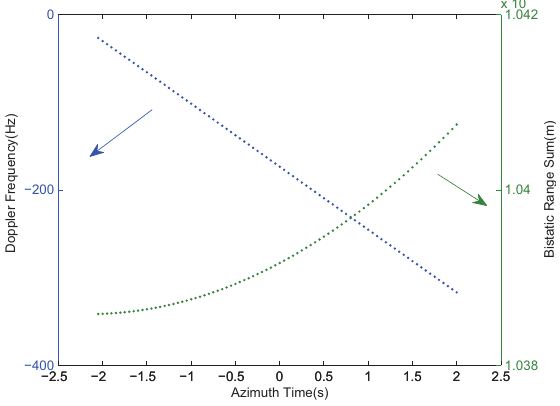
Figure 4. Relationship between Doppler frequency, bistatic range sum and azimuth time.